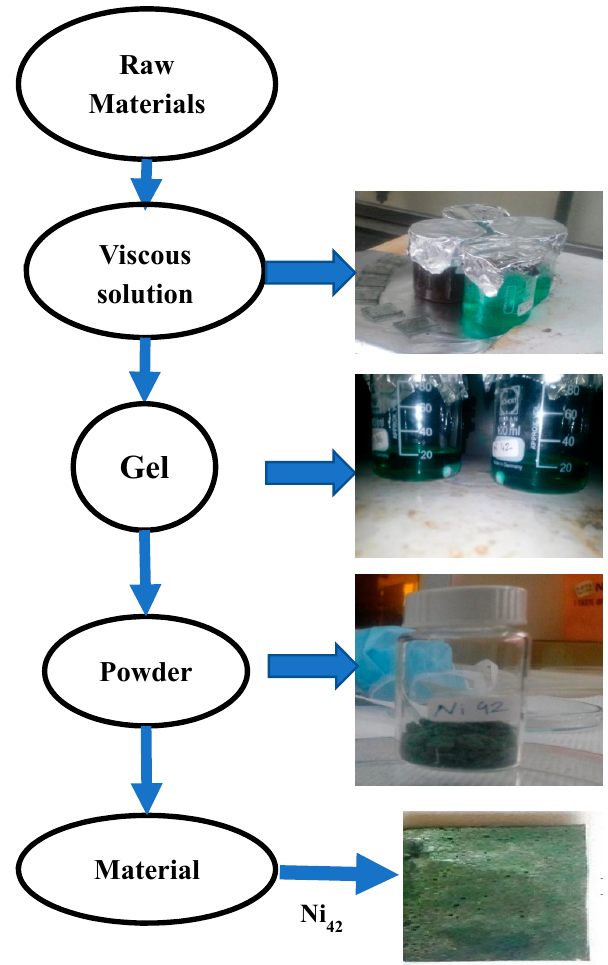
Figure 3. Preparation flowchart and process of fabrication of nickel aluminate (NiAl 2 O 4 ) material.